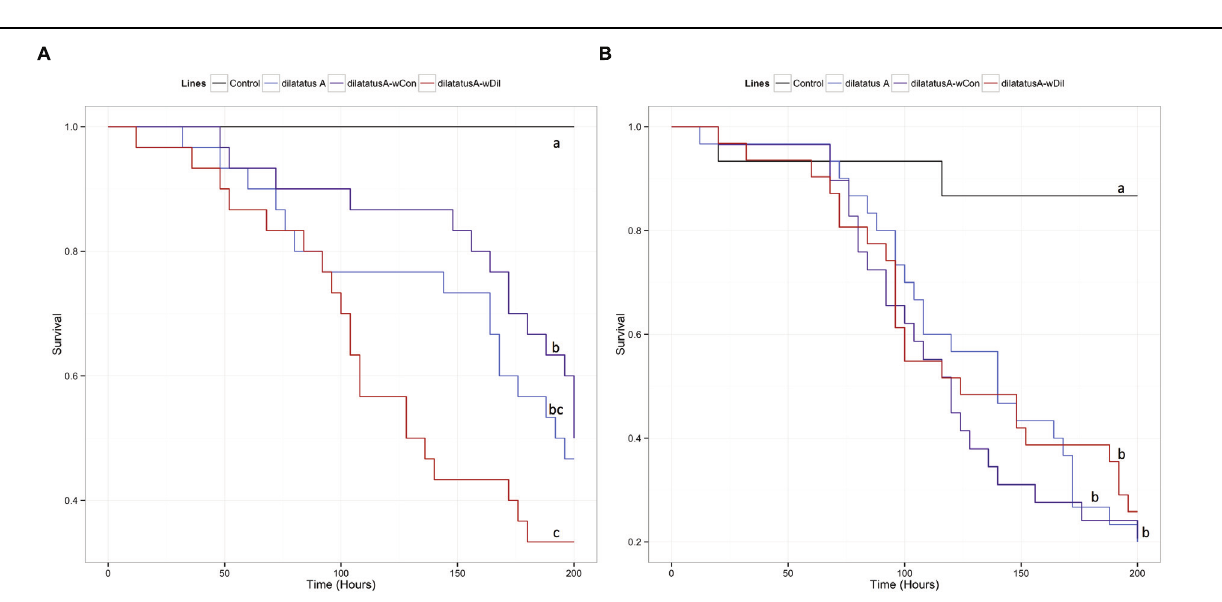
test, χ 2 = 0.2, df = 1, p = 0.683, Figure 3A ; males: dilatatus A and dilatatus A- w Con: log-rank test, χ 2 = 0.6, df =